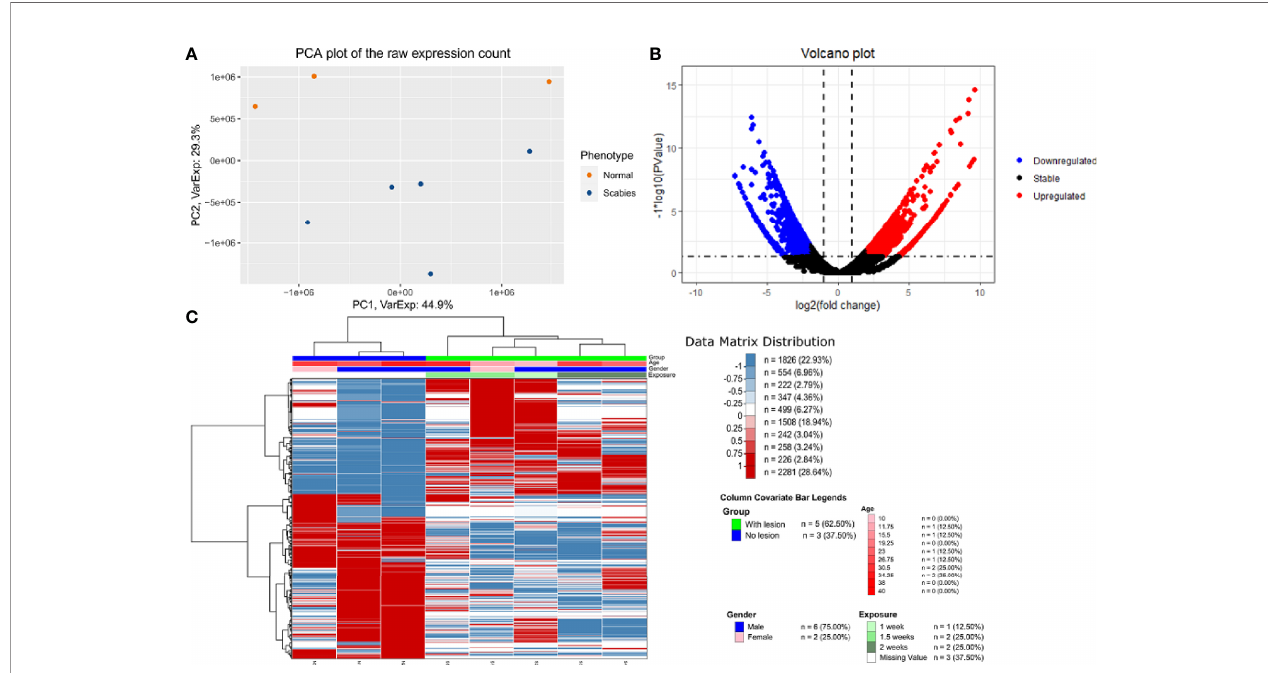
FIGURE 2 | Transcriptome pro fi le of human skin biopsies infested with mite ( S. scabiei var. hominis ) (A) PCA plot using raw RNA-seq expression counts of eight samples (three control and fi ve OS samples). (B) Volcano plot of differential expression pro fi le of all genes with upregulated (p < 0.05 and logFC>2) and downregulated (p < 0.05 and logFC < 2) genes shown in red and blue respectively. (C) NGCHM plot of top 1,000 differentially expressed genes using unsupervised hierarchical clustering in both directions (rows and columns). Covariates include age, gender, and duration of exposure and diseased group (With lesion represents OS samples, and No lesion represents control